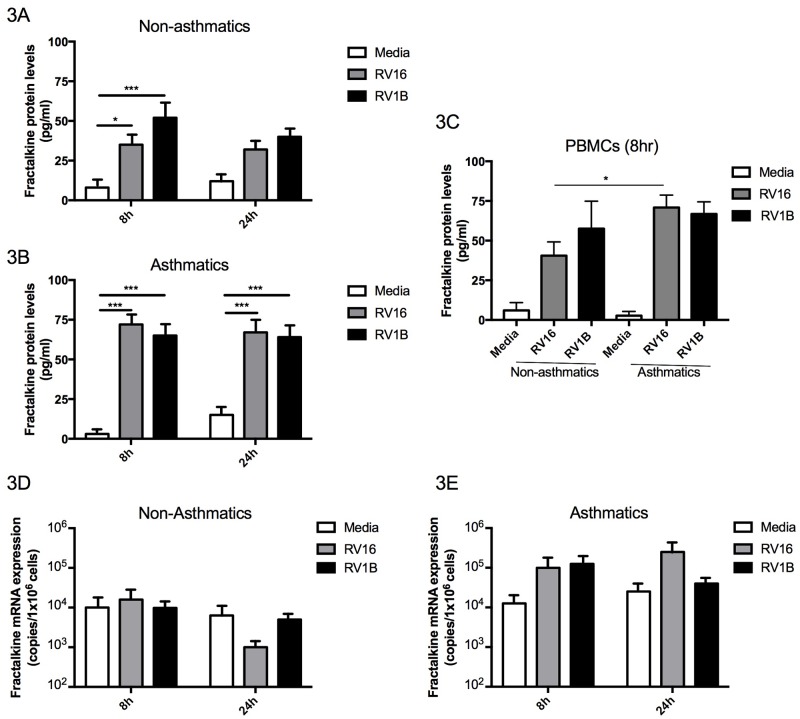
Change in levels of fractalkine in PBMCs following in vitro infection with RV16 and RV1B.Soluble fractalkine protein was measured in cell supernatants from PBMCs obtained from (A) non-asthmatic (n = 15) and (B) asthmatic (n = 15) subjects and compared between subject groups at 8hrs post infection (C). Fractalkine mRNA expression was measured in PBMC cell lysate cDNA obtained from (D) non-asthmatic and (E) asthmatic subjects. The results are expressed as mean ± SEM. Protein data were analysed by one-way ANOVA with Bonferroni post-test and mRNA by Kruskal Wallis with Dunn’s post test (*P<0.05, ***P<0.001).